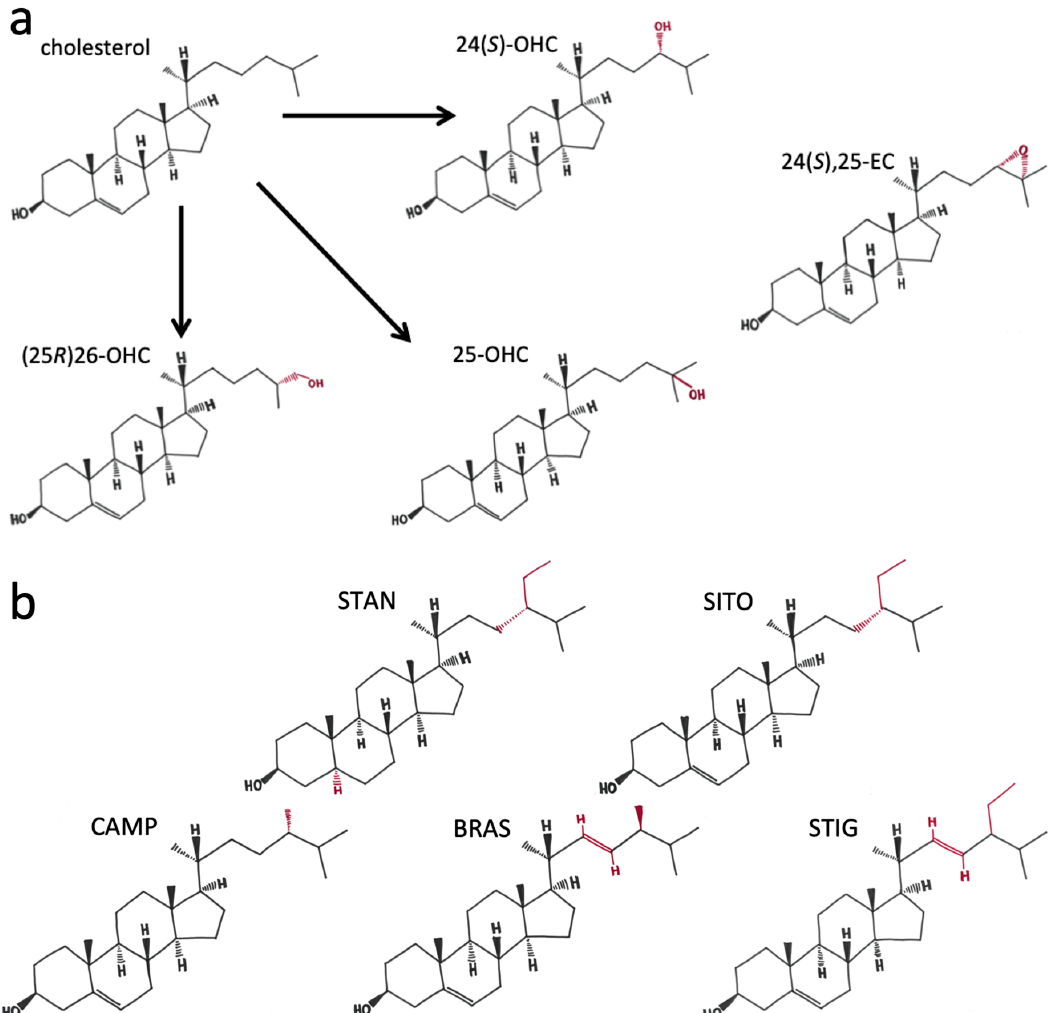
Figure 1. Chemical structure of cholesterol, side-chain oxysterols and plant sterols/stanols: ( a ) cholesterol differences from oxysterols 24( S )-OHC, 25-OHC, (25 R )26-OHC and 24( S ),25-EC are highlighted; ( b ) structures of phytostanol (sitostanol (STAN)) and phytosterols ( β -sitosterol (SITO); campesterol (CAMP); brassicasterol (BRAS); stigmasterol (STIG) used in this study. Differences in structure with cholesterol are shown in red.